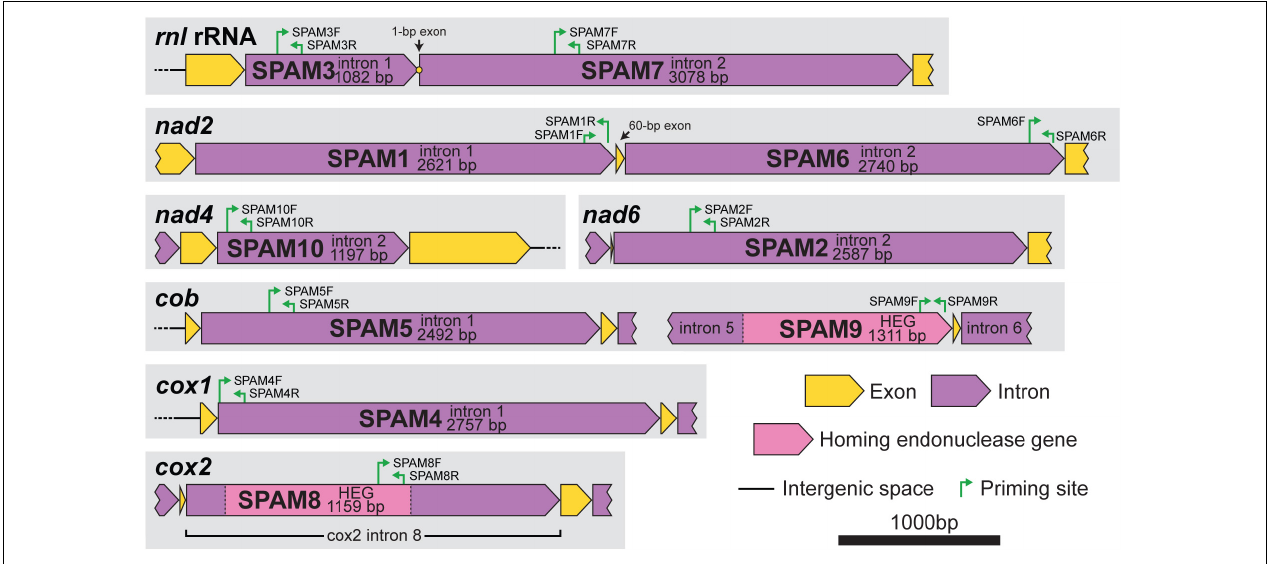
FIGURE 1 | Gene context and map of standard primers (internal primers used for PCR surveys) for each of the 10 heterogenous mitochondrial elements (SPAM1–SPAM10) in Ceratocystis lukuohia. Primer sequences are detailed in Table 2 . All regions are to scale; bar = 1,000 bp.